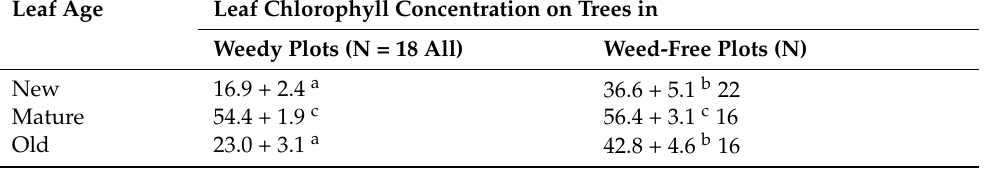
Table 4. SPAD chlorophyll readings for mango leaves, weeds vs. weed-free, total chlorophyll per unit leaf area (nmol/cm 2 ). Univariate ANOVA comparisons. Letter superscripts indicate differences in mean SPAD readings within and between